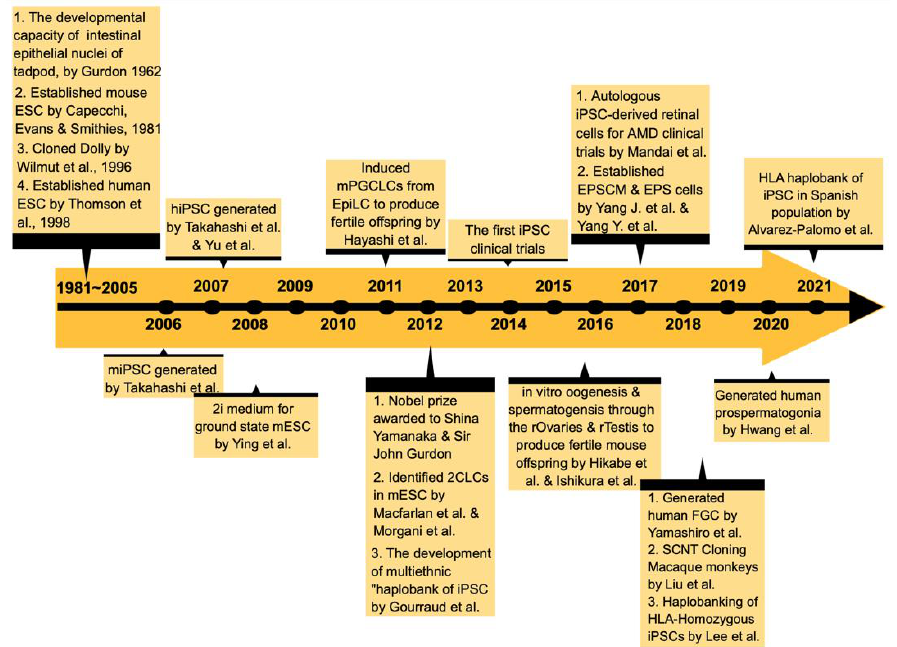
Figure 1. The timeline of significant scientific advances in the history of nuclear and somatic reprogramming research. The phenomenon of nuclear reprogramming was observed in the early 1960s via SCNT and heterokaryon experiments. In 1997, the cloning of Dolly served as a monument of mammalian cloning and addressed the plasticity characteristic in mammals’ genomes. Furthermore, the cloning of the Macaque monkey counted as a recent breakthrough in the nuclear reprogramming field. Along with the advances of stem cell biology, the unraveling of pluripotent network formation and new culture approaches (e.g., 2i medium and feeder-free) accelerated iPSC development and further allowed for capturing and maintaining EPS cells (expanded potential stem cells) in vitro. Another crucial breakthrough was the production of the hiPSC-derived RA-responsive FGC formation. All of these advances contributed to the first clinical trials of hiPSC- derived retinal cell transplants.